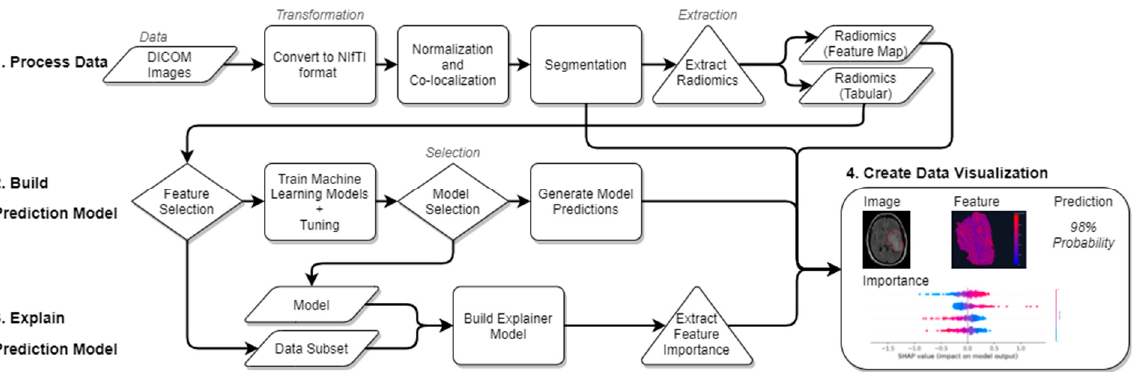
Figure 1. Methods Overview. Information enters the pipeline as DICOM images and then proceeds sequentially through the “Process Data”, “Build Prediction Model”, and “Explain Prediction Model” sub-pipelines, while select outputs are combined into a visual dashboard.